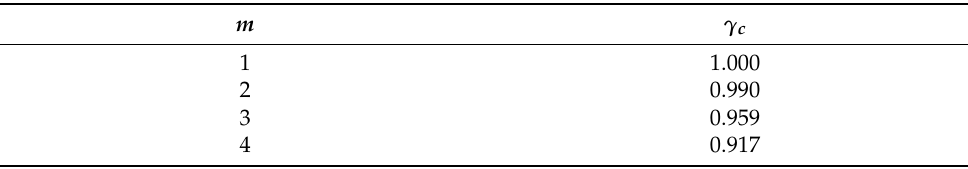
Table 4. The relationship between γ c and m when α =